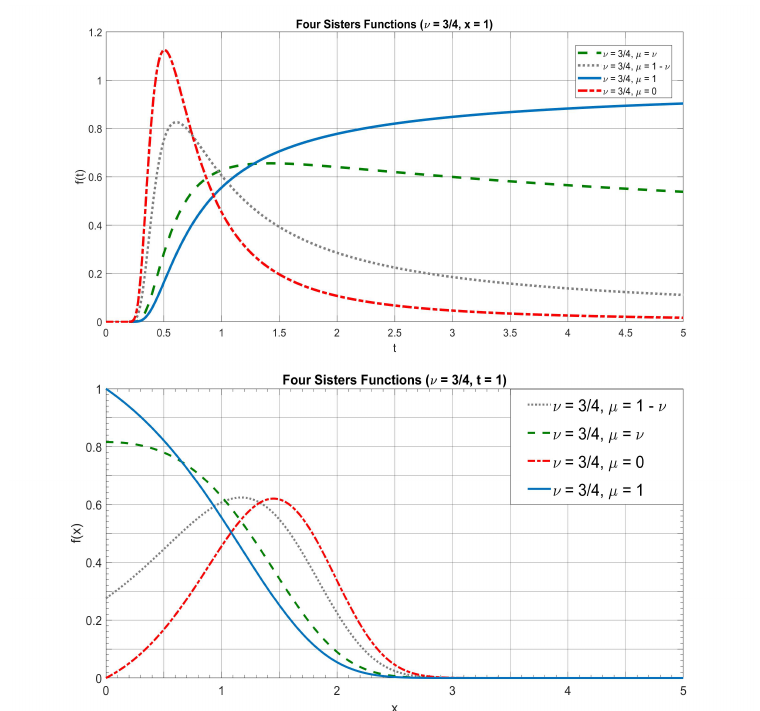
Figure 9. Plots of the four sisters functions in linear scale with ν = 3/4; top: versus t ( x = 1), bottom: versus x ( t =